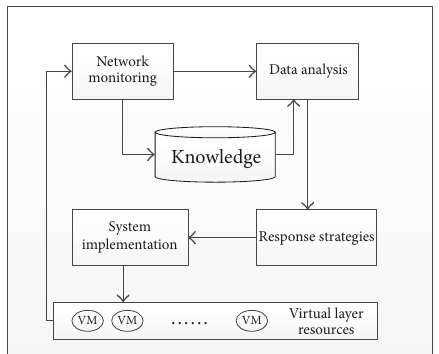
Figure 2: The cloud security monitoring model based on autonomic